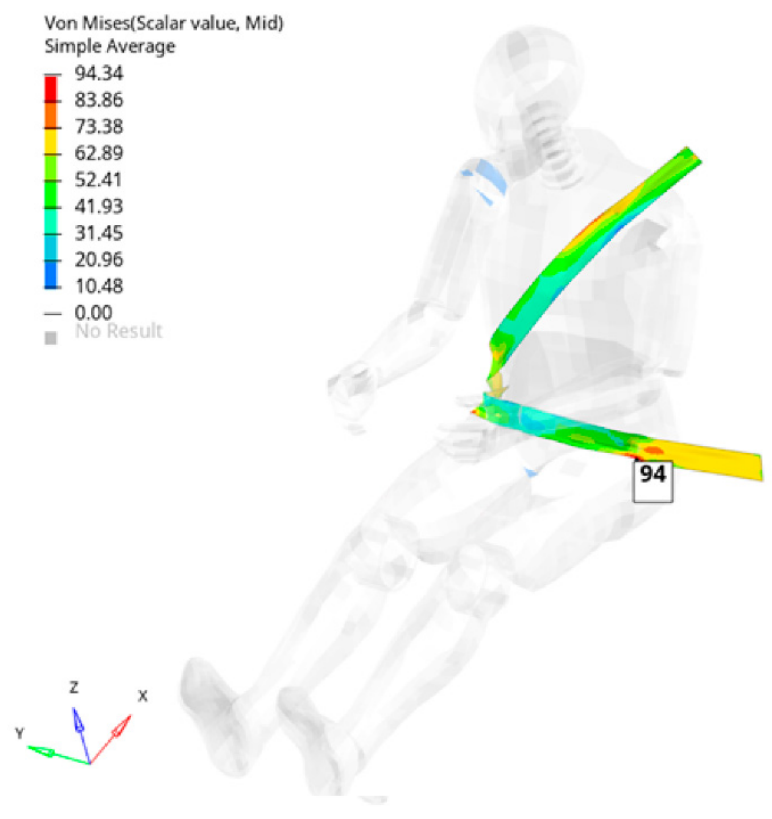
Figure 14. Stress in the belt when T = 0.035 s (in MPa).